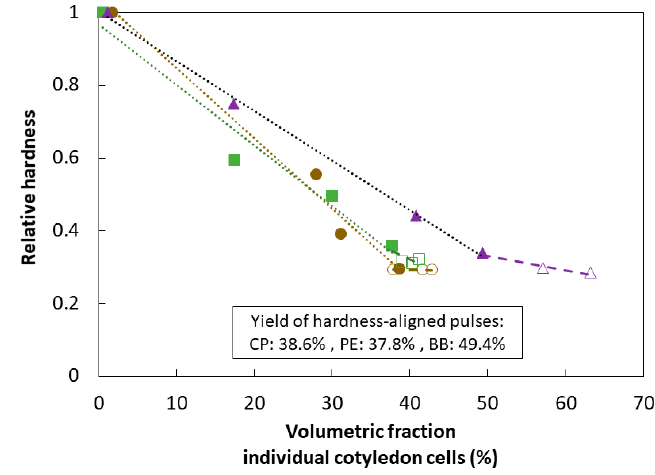
Figure 3. Quantitative evaluation of the individual cotyledon cell fraction determined by particle size distribution as a function of the relative residual hardness after processing for chickpea (CP) ( • ), pea (PE) ( (cid:4) ), or black bean (BB) ( (cid:78) ) material. Means of triplicate evaluations are presented. Filled symbols ( • ) are linked to the time domain for which hydrothermal processing resulted in hardness decay. Open symbols ( ) are linked to the time domain for which extended hydrothermal (cid:35) processing did not further affect the hardness level (e.g., plateau region). Dotted lines show fitted linear trendlines for each of the two domains (i.e., hardness decay versus hardness